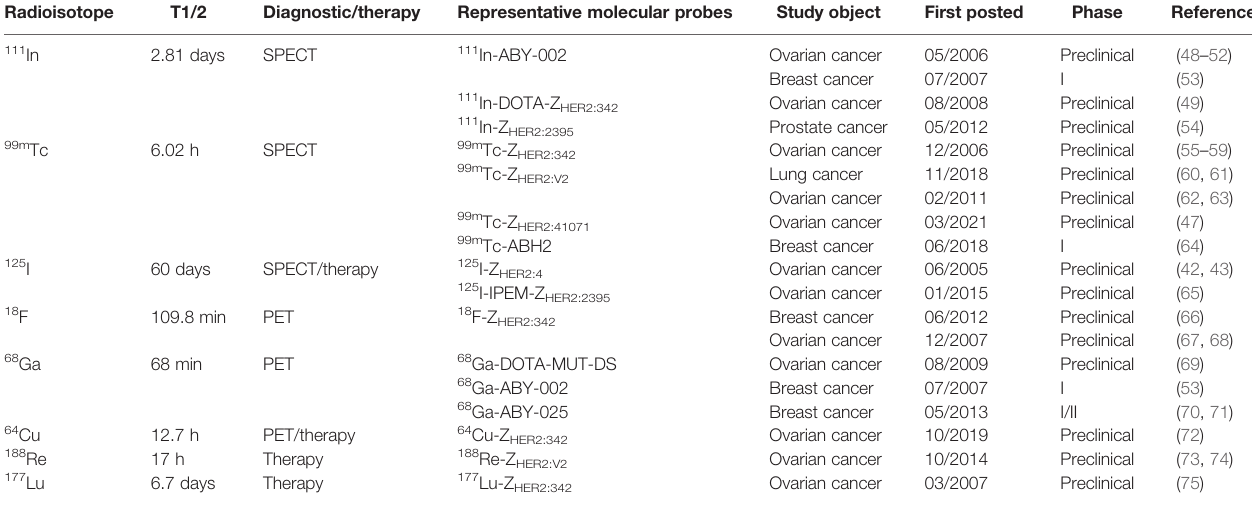
TABLE 1 | Overview of the major applications of radionuclide-labeled HER2 af fi body molecular probes. Radioisotope